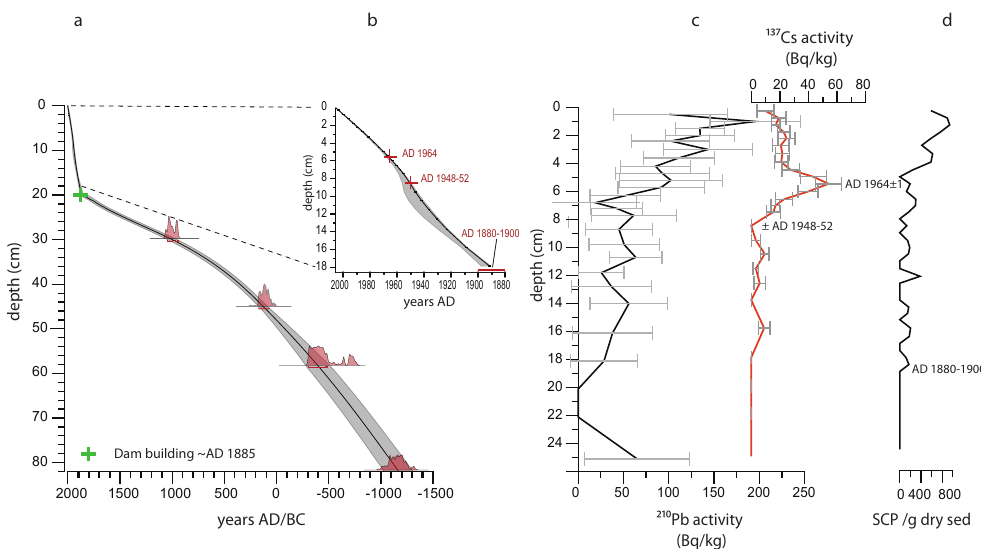
Fig. 2. (a) Full age depth model, based on radiocarbon dates for the lower part (probability distribution of each sample shown), the dam building phase around 20 . 2 ± 1cm at AD1885 ± 5yr, and the SIT model for the upper part. The SIT model and associated errors are shown in detail in (b) . The SIT model was based on measured 210 Pb activity (shown in c ) and constrained by the clear 137 Cs peak at 5.7cm depth. The additional, independent marker horizons derived from the onset of 137 Cs activity (8.2cm) (c) and the first appearance of Spheroidal Carbonaceous Particles (18.2cm) are also shown (d)